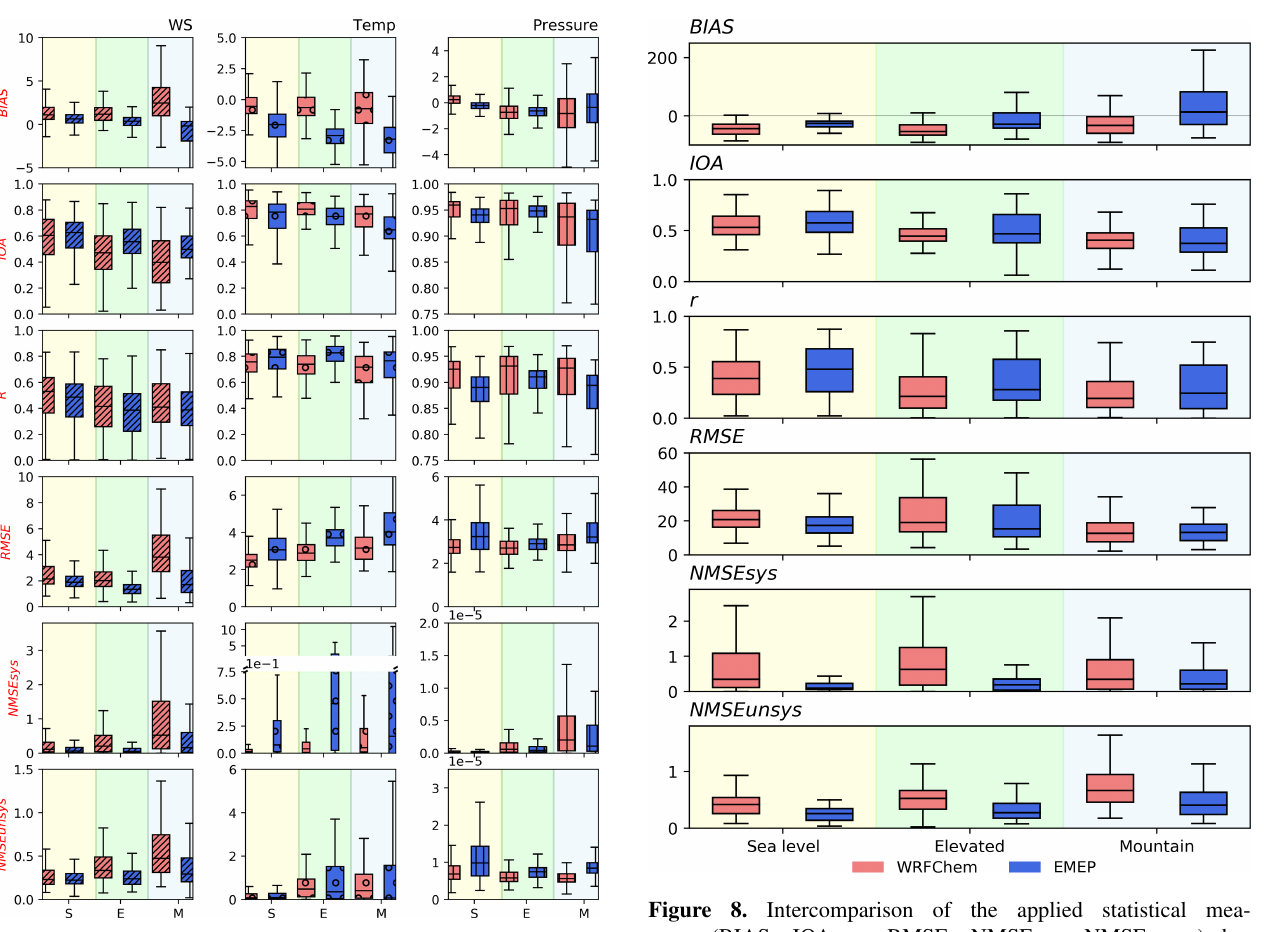
Figure 7. Intercomparison of the applied statistical measures (BIAS, IOA, r , RMSE, NMSEsys, NMSEunsys) between modelled (WRF-Chem – red boxes; EMEP – blue boxes) and measured (from 920 meteorological stations across all of Europe, source: Ogimet (https://www.ogimet.com/, last access: 12 May 2020.)) wind speed (WS, //), temperature (Temp, ◦◦ ) and surface pressure (Pressure, || ) during November 2011 for sea-level (S), elevated (E) and mountain (M) stations. The units of selected meteorological parameters are metres per second for wind speed, degrees Celsius for temperature and hectopascal for surface pressure.